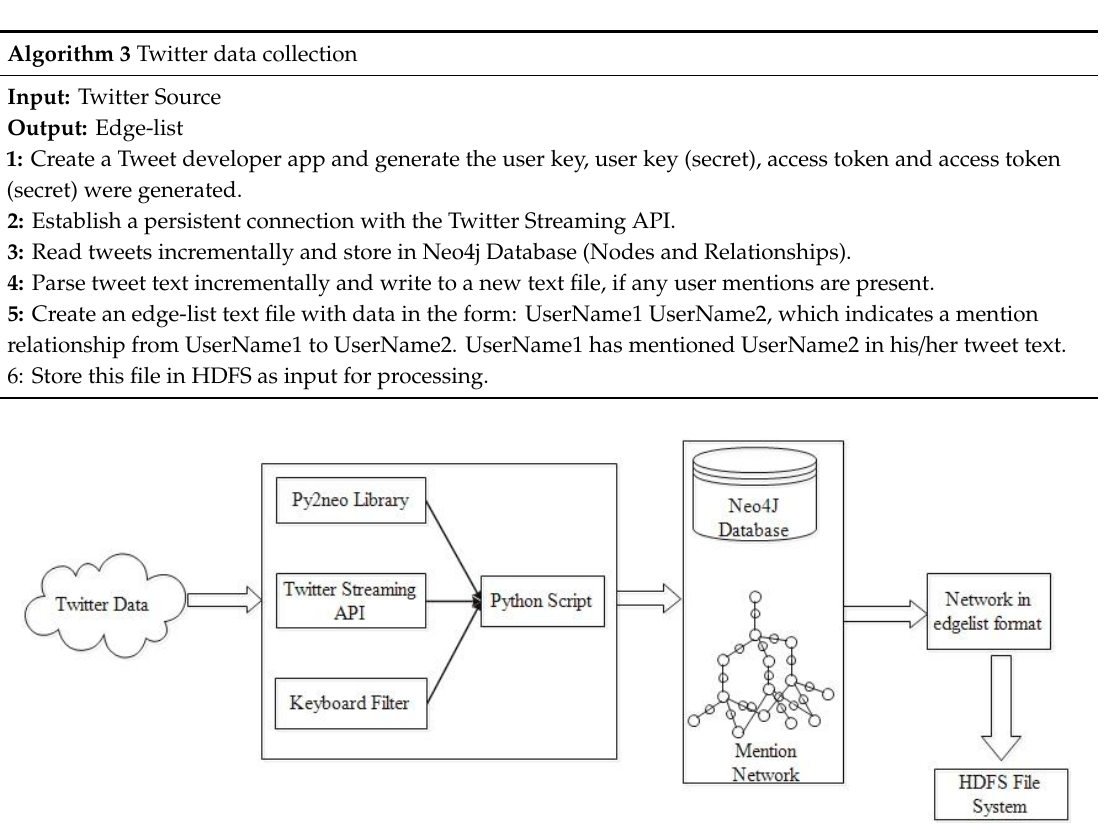
Figure 2. Architecture used for Data Collection.